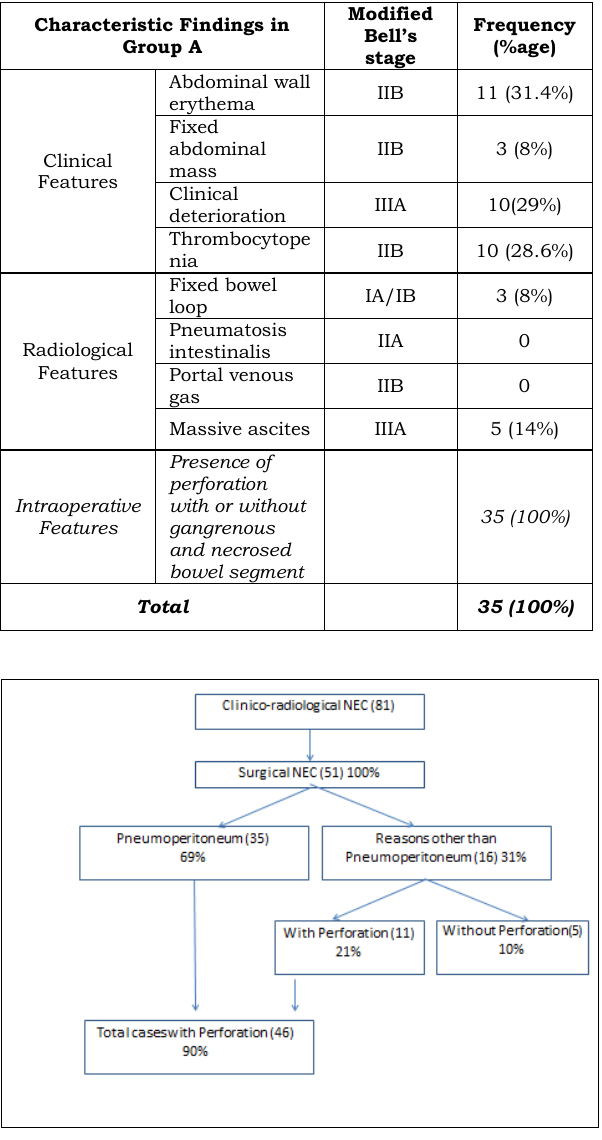
Table 4: Clinical, radiological, and operative findings in Group A patients Characteristic Findings in Group A